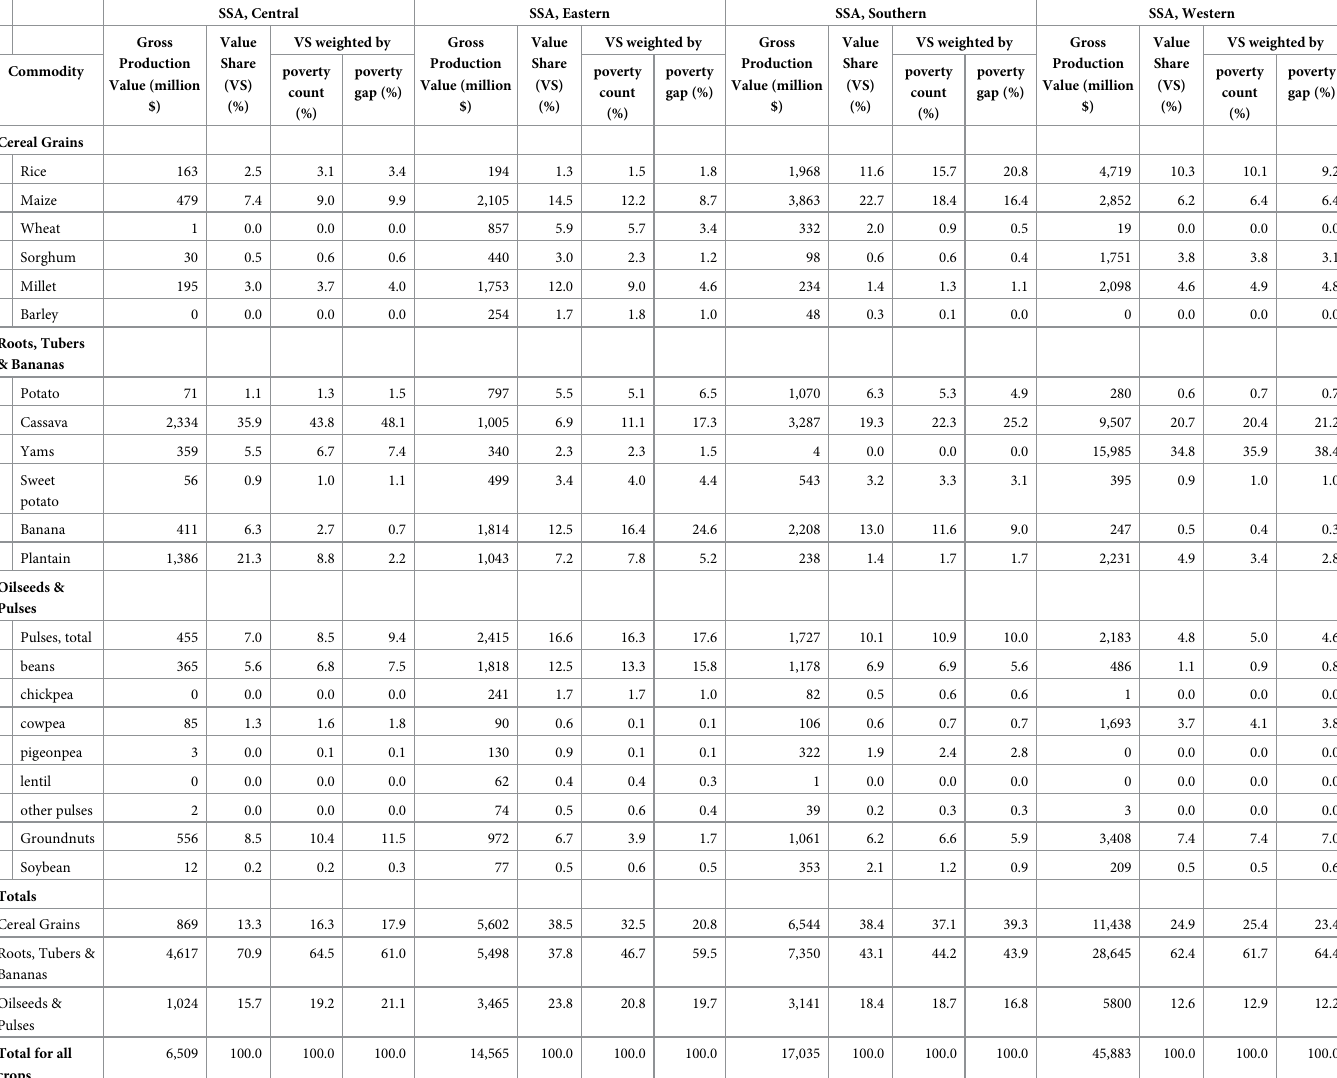
Table 5. Parity model results: Gross production value from FAOSTAT in 2015, by subregion in Sub-Saharan Africa. SSA,Central SSA,Eastern SSA,Southern